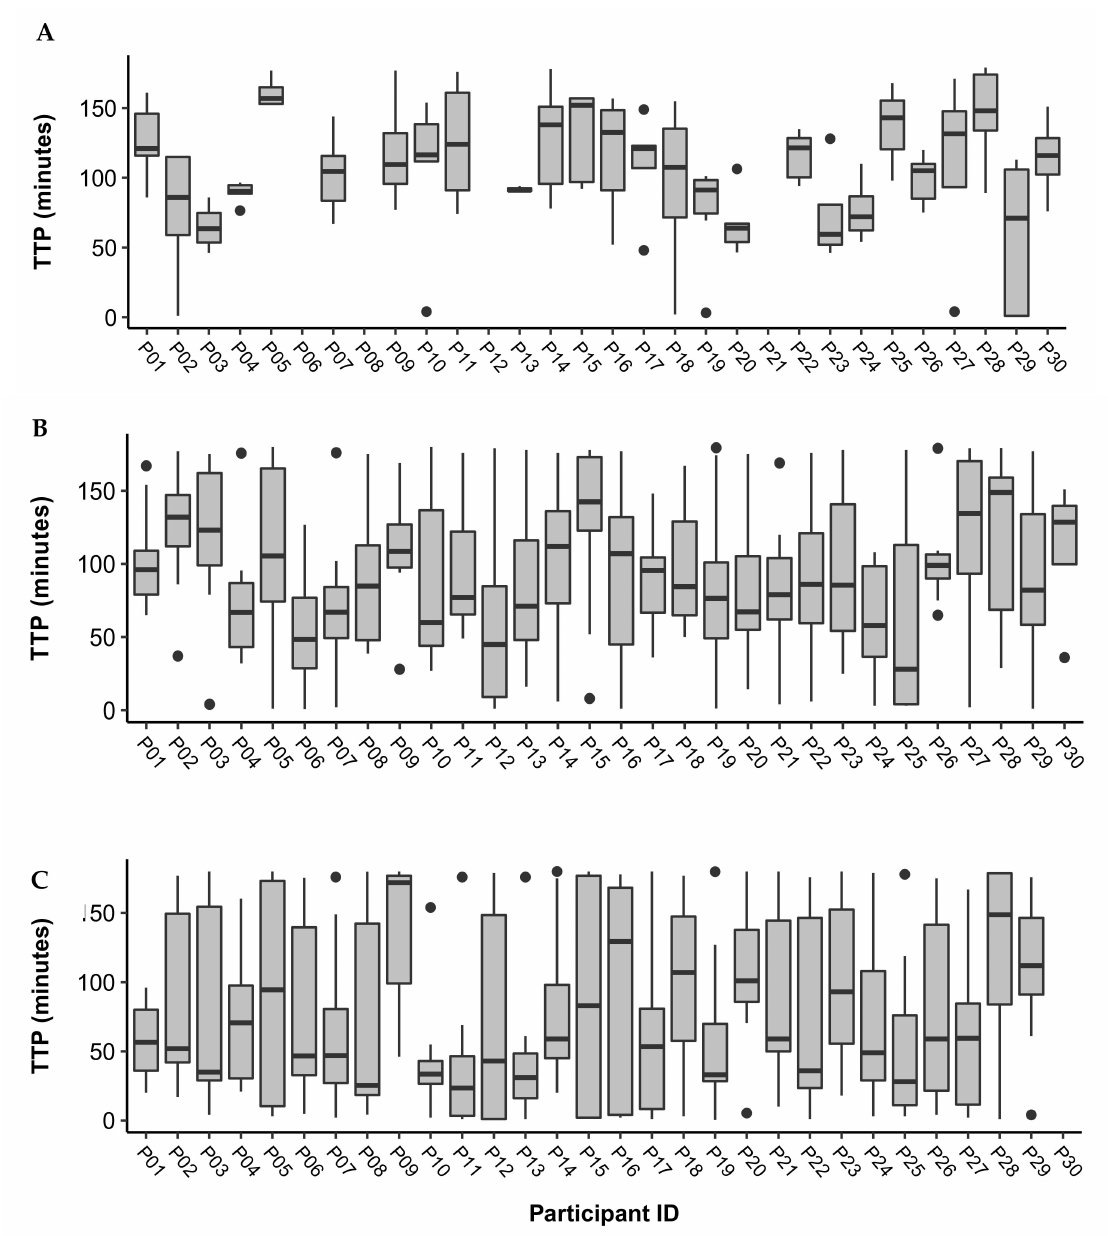
Figure 1. Boxplots of time to peak (TTP) in minutes across study days for participants during the ( A ) Controlled, ( B ) FLB, and ( C ) FLD periods. Outliers are represented by black dots. The mean (SD) study days included in the analysis for each participant was 5 (1) days for the controlled period; 12 (2) days for FLB, and 10 (2) days for